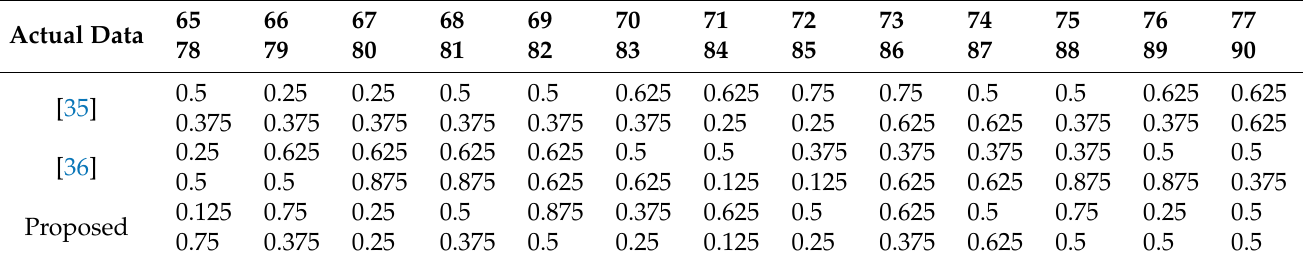
Table 7. Comparisons of the avalanche effect of avalanche effect of A–Z using S-BOX1 of the proposal and traditional